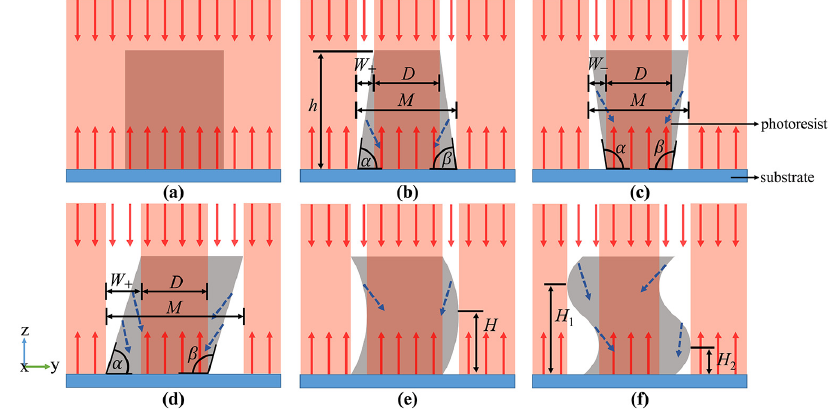
Figure 2. Schematic diagram of light reflected by structures with different shapes. ( a ) Standard rectangular structure; ( b ) trapezoidal structure with acute base angle; ( c ) trapezoidal structure with obtuse base angle; ( d ) tilted structure; ( e ) C-shape distorted structure; ( f ) S-shape distorted structure.